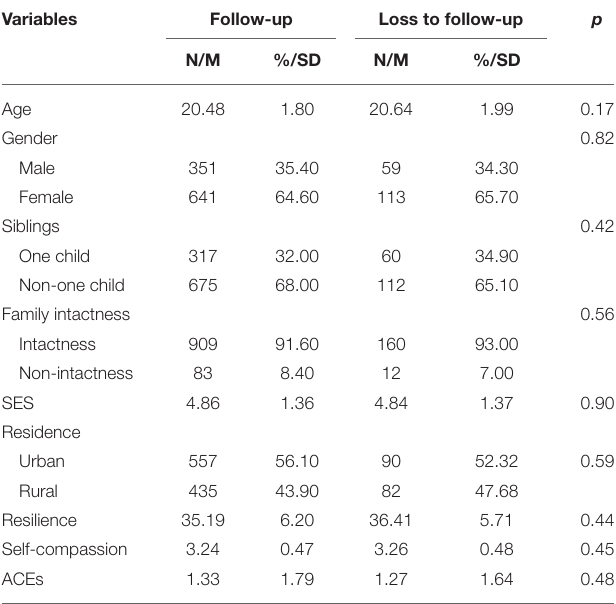
TABLE 1 | Comparisons of psychosocial variables and PTSS of the participants measured at Wave 1 by loss to follow-up.